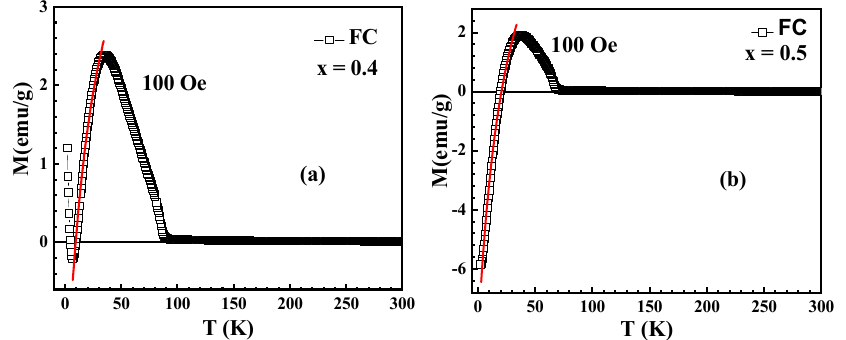
Figure 6. ( a , b ): The FC magnetization curves fitted to Equation (1) for compounds with x = 0.4 and x = 0.5 measured under 100 Oe magnetic field. Table 2. List of fitting parameters for negative magnetization of 𝑀–𝑇 curves in FC mode as shown in Figure 6a,b. − 24.59 Figure 7a–f express the inverse of magnetic susceptibility ( 𝜒 (cid:2879)(cid:2869) ) versus temperature ( T ) plots of GECMO compounds measured at 100 Oe applied magnetic field. In the